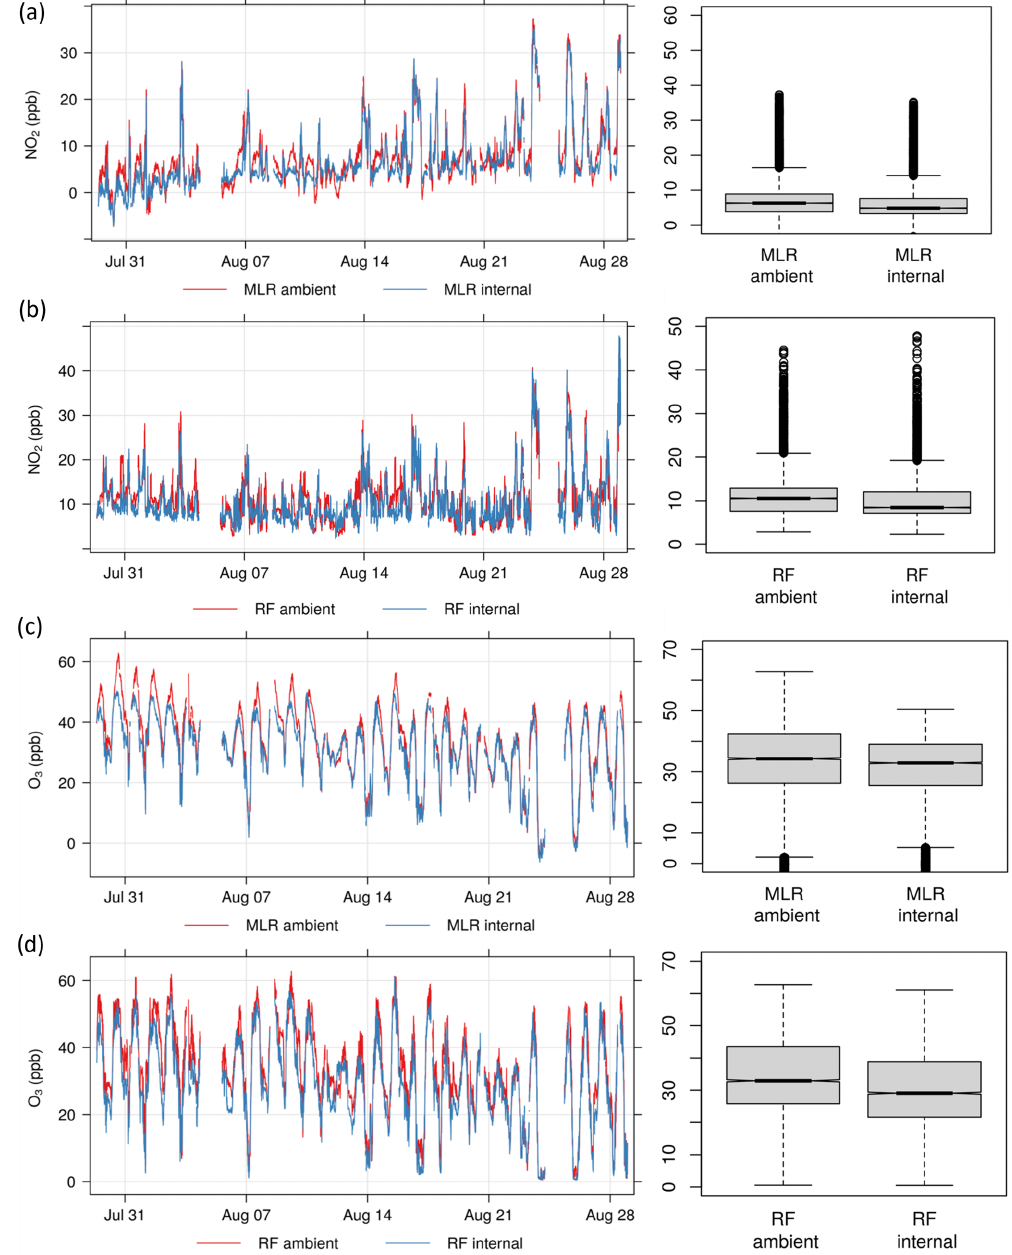
Figure 11. Time series plots and boxplots for Experiment 1 of (a) predicted NO 2 concentrations using the MLR model, (b) predicted NO 2 concentrations using the RF model, (c) predicted O 3 concentrations using the MLR model, and (d) predicted O 3 concentrations using the RF model. “Ambient” and “internal” refer to the use of ambient or internal T and RH data in each model. Multicollinearity is an issue common not only to